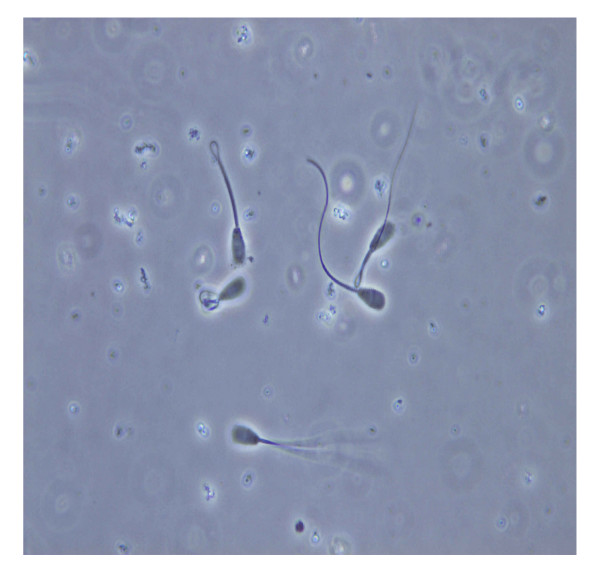
Inactive sperms and different swelling patterns of the active sperms after HOS test (1000×).